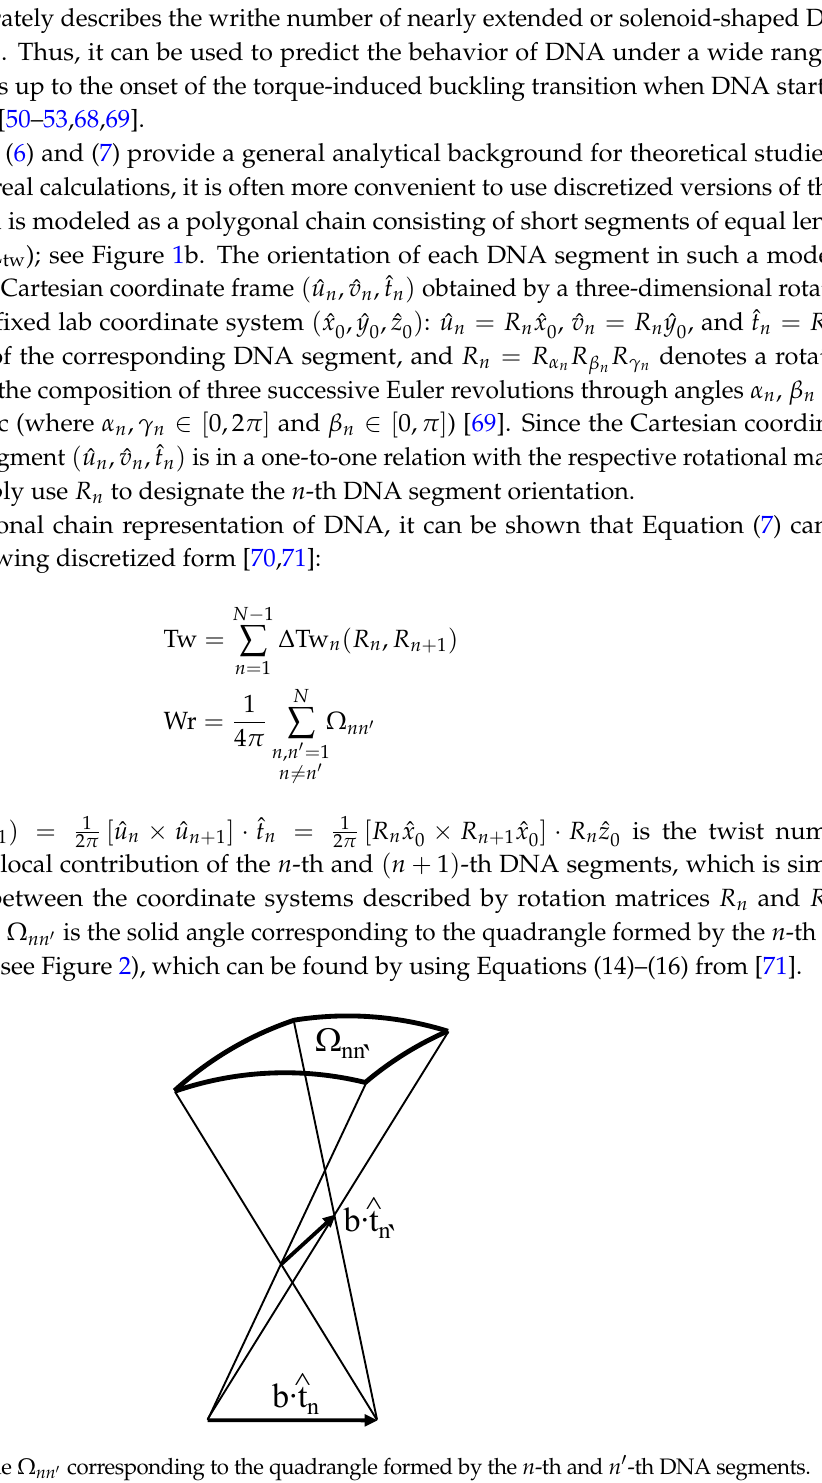
Figure 2. Solid angle Ω nn (cid:48) corresponding to the quadrangle formed by the n -th and n (cid:48) -th DNA